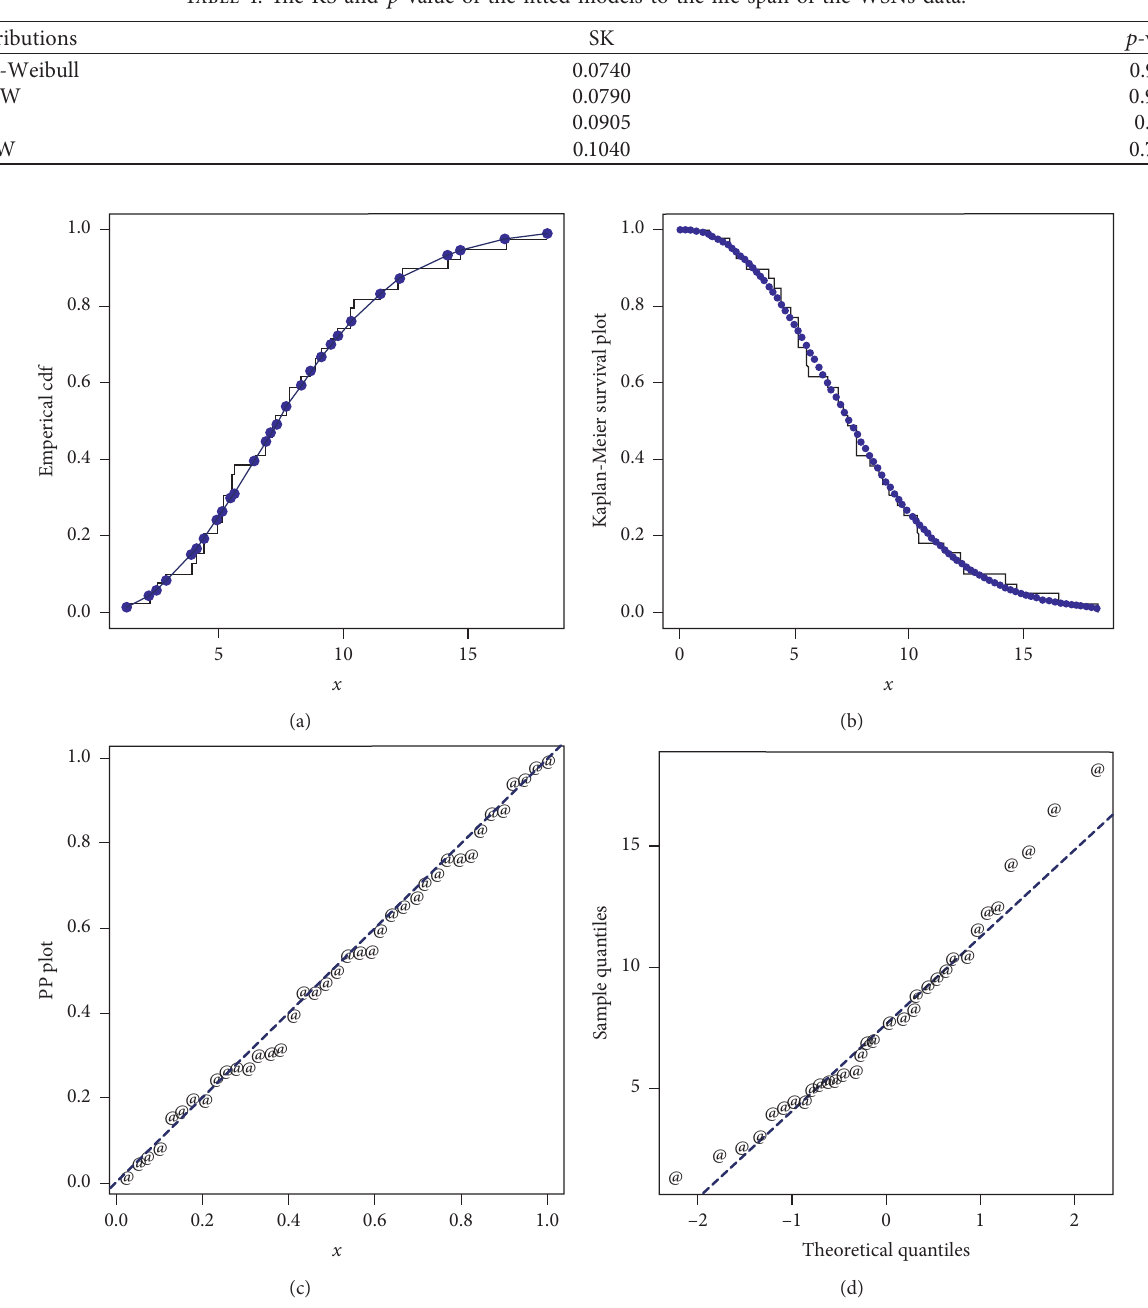
Figure 8: The empirical cdf and Kaplan–Meier survival, PP and QQ plots of the NEP-Weibull distribution for the life span of the WSNs